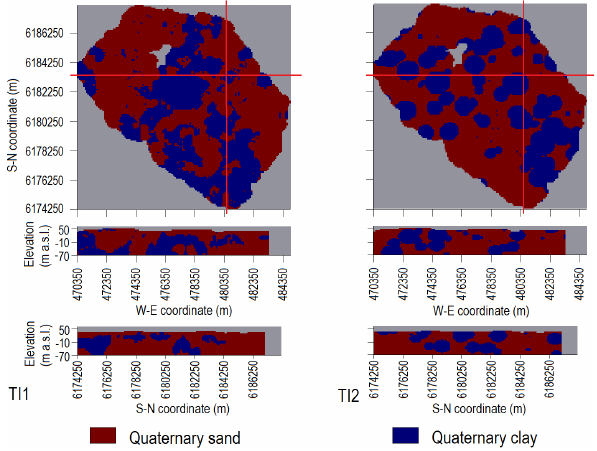
Figure 7. Cross sections of TI1 and TI2. TI1 is converted from Figure 7: Cross sections of TI1 and TI2. TI1 is converted from SkyTEM data while TI2 is 2 SkyTEM data while TI2 is generated by TiGenerator. The horizon- generated by TiGenerator. The horizontal plane is taken at 10 m a.s.l.. 3 tal plane is taken at 10ma.s.l.